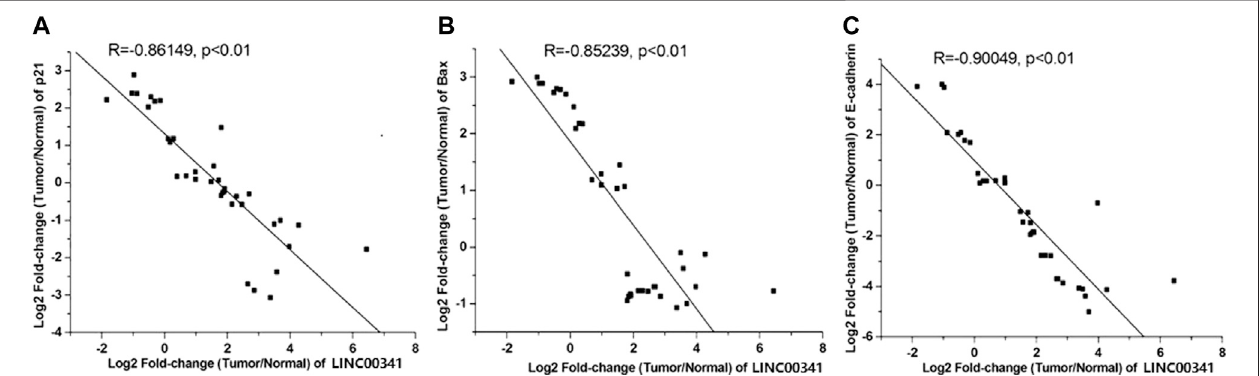
Frontiers in Molecular Biosciences |